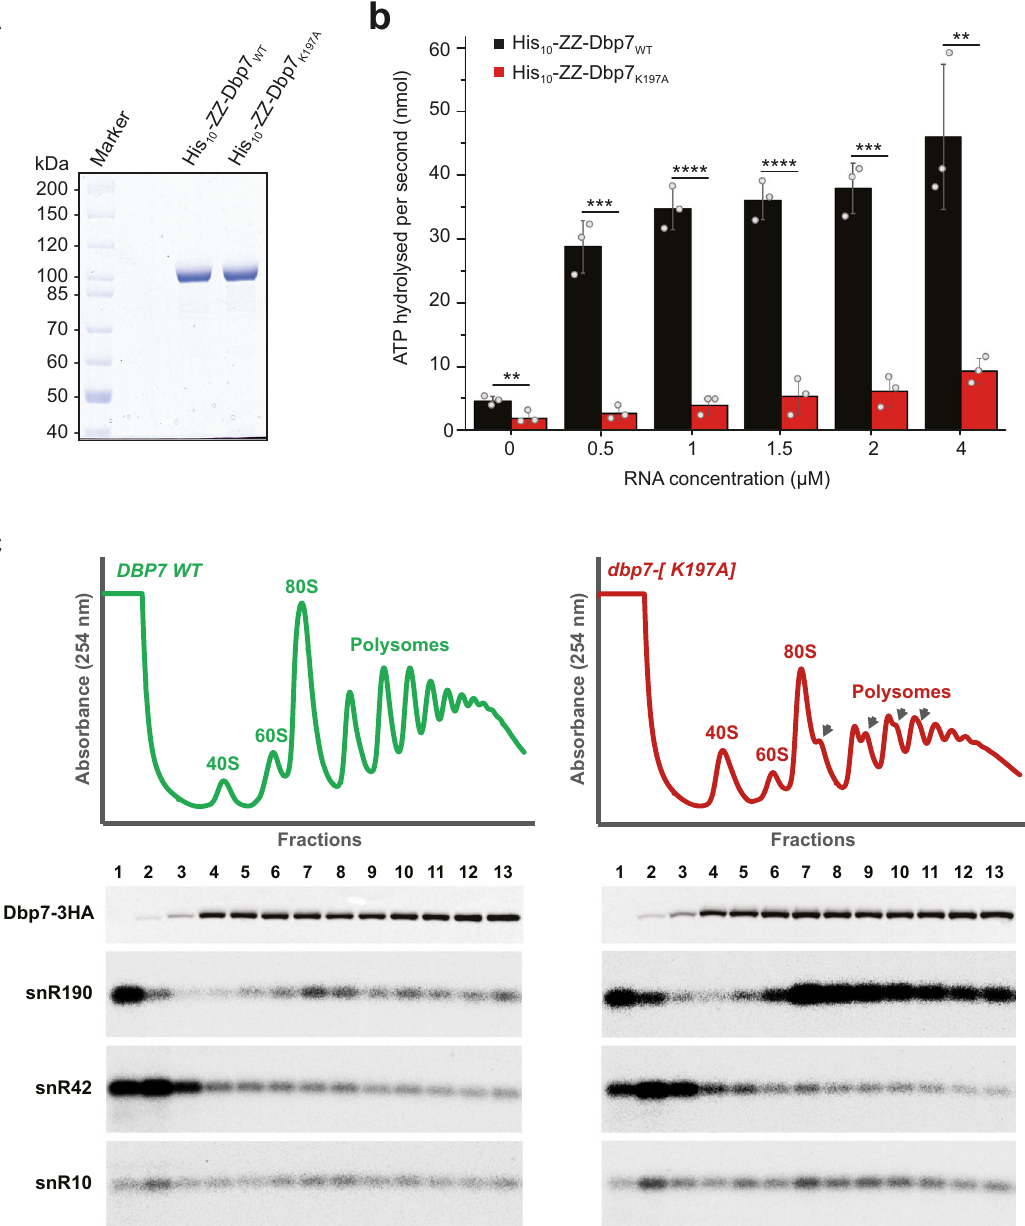
Fig. 6 The ATPase activity of Dbp7 is required for snR190 release from preribosomal particles. a His 10 -ZZ-tagged Dbp7 WT and Dbp7 K197A were recombinantly expressed in E. coli and puri fi ed by nickel-af fi nity chromatography. Puri fi ed proteins were separated by denaturing SDS-PAGE and visualized by Coomassie staining. b The rate of ATP hydrolysis by puri fi ed His 10 -ZZ-Dbp7 WT (black) and Dbp7 K197A (red) was monitored using an in vitro NADH- coupled ATPase assay in the presence of increasing amounts of RNA. Data from three independent experiments are presented as mean ± standard deviation. Statistically signi fi cant differences determined using one-tailed Student ’ s t -test are indicated by asterisks (0 µ M RNA: ** p < 0.01 (0,008696); 0.5 µ M RNA: *** p < 0.001 (0,000217); 1 µ M RNA: **** p < 0.0001 (0,000061); 1.5 µ M RNA: **** p < 0.0001 (0,000106); 2 µ M RNA: *** p < 0.001 (0,000139); 4 µ M RNA: ** p < 0.01 (0,002657). c Sedimentation pro fi le of Dbp7-3HA and snR190, snR42, and snR10 snoRNAs in cells expressing Dbp7 K197A . Total cellular extracts prepared from the dbp7 Δ strain transformed with vectors encoding 3HA-tagged versions of Dbp7 WT (green) or Dbp7 K197A (red) were centrifuged through 10 – 50% sucrose gradients. A 254 was measured during gradient fractionation and the pro fi les are represented. Proteins and RNAs extracted from the fi rst 13 fractions were analyzed by western blotting and northern blotting, respectively, to detect wild-type or mutant Dbp7-3HA proteins and snoRNAs. This experiment has been performed once with the strain expressing the Dbp7 K197A catalytic mutant and once with the dbp7 Δ strain (Fig. 5c) with similar results for the snoRNAs (TAP) tag in wild-type (BY4741), snr190-[mut.C] , and dbp7 Δ less ef fi ciently co-puri fi ed with Noc1-TAP compared to the wild- strains. The RNAs and proteins co-puri fi ed with Noc1-TAP in type conditions. This effect was not due to a lesser immunopre- each condition were analyzed by northern and western blotting, cipitation ef fi ciency of early preribosomes as the levels of the 35S, respectively (Fig. 8). In the absence of snR190, all tested members 33S/32S, and 27SA 2 precursors were slightly higher in the Noc1- TAP-puri fi ed sample obtained from the snr190-[mut.C] strain, as of the Npa1 complex, namely Npa1, Dbp6, Nop8, and Rsa3, were